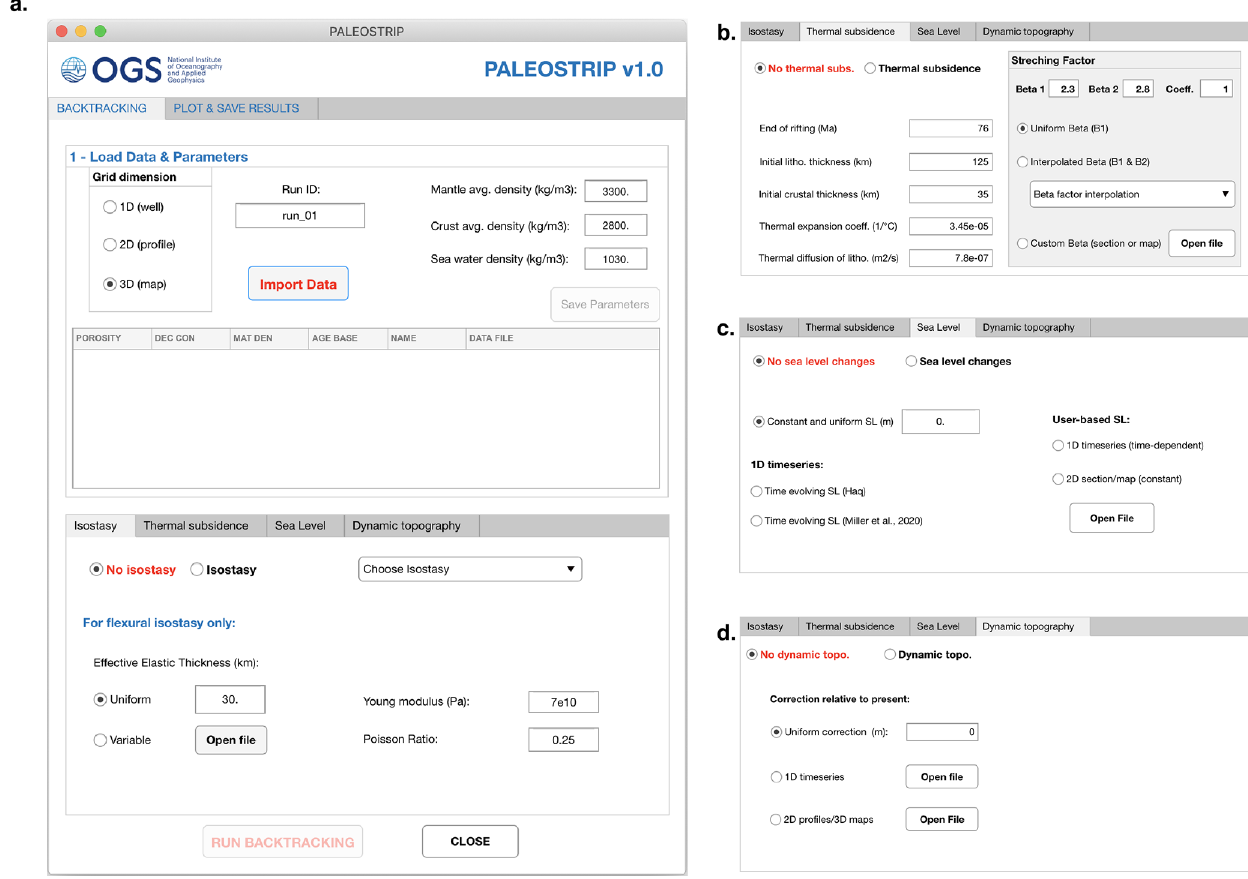
Figure 1. Example of the PALEOSTRIP application GUI, showing this following elements: (a) the main PALEOSTRIP GUI, (b) tab interface to set thermal subsidence (bottom of main GUI), (c) tab interface to set sea level corrections, and (d) tab interface to set dynamic topography